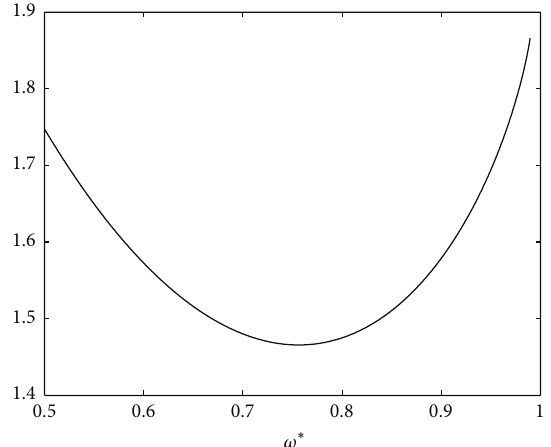
Figure 8: Plot of the l.h.s. of (64) with respect to the possible equilibrium fractions 𝜔 ∗ ∈ [ 1 / 2 , 1 − 1 /𝑁) .